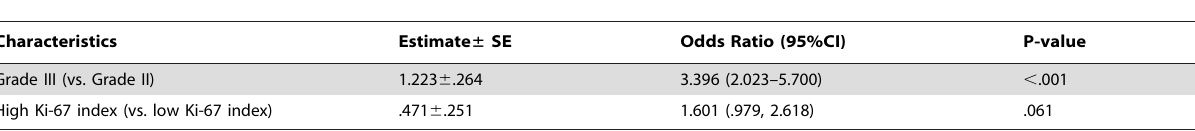
Table 2. Multivariable logistic regression model for PR negativity.